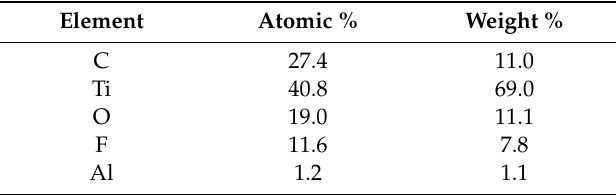
Table 1. Element content of Ti 3 C 2 T x MXene nanosheets.